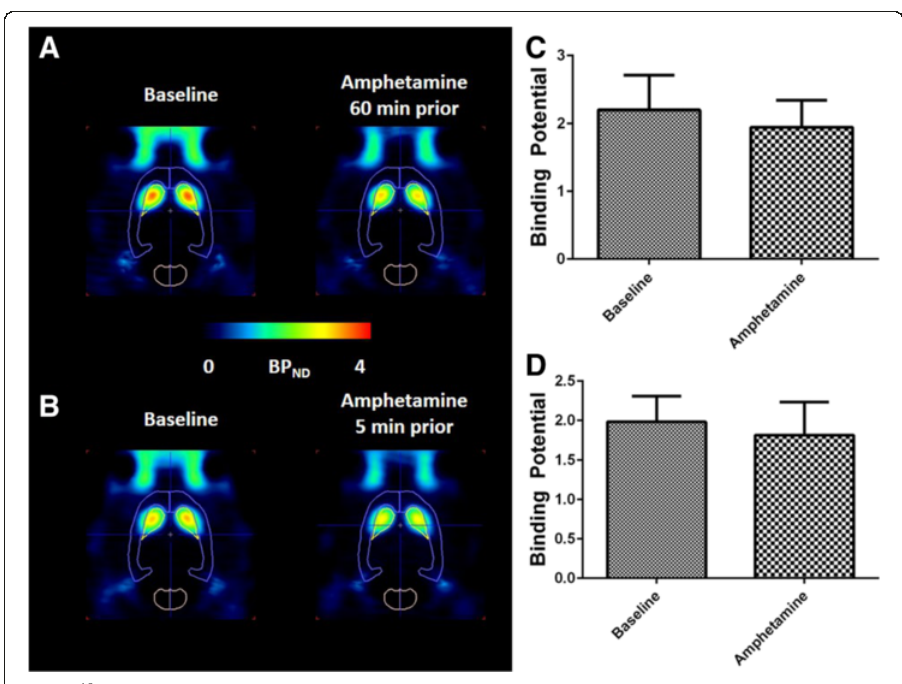
Fig. 1 [ 18 F]JNJ42259152 BP ND values after acute amphetamine treatment. Left : Transversal images of PDE10A binding in the brain at baseline conditions vs 60 min after s.c. amphetamine treatment ( a ) and at baseline conditions vs 5 min after i.v. amphetamine treatment ( b ). Images are overlaid on a VOI map and presented as averaged, parametric BP ND images (Logan Reference) at baseline conditions and amphetamine treated conditions. Right : Comparison of BP ND in striatum at baseline conditions and 1 h after subcutaneous injection of amphetamine ( c ) and 5 min after intravenous injection of amphetamine ( d ). No significant difference was